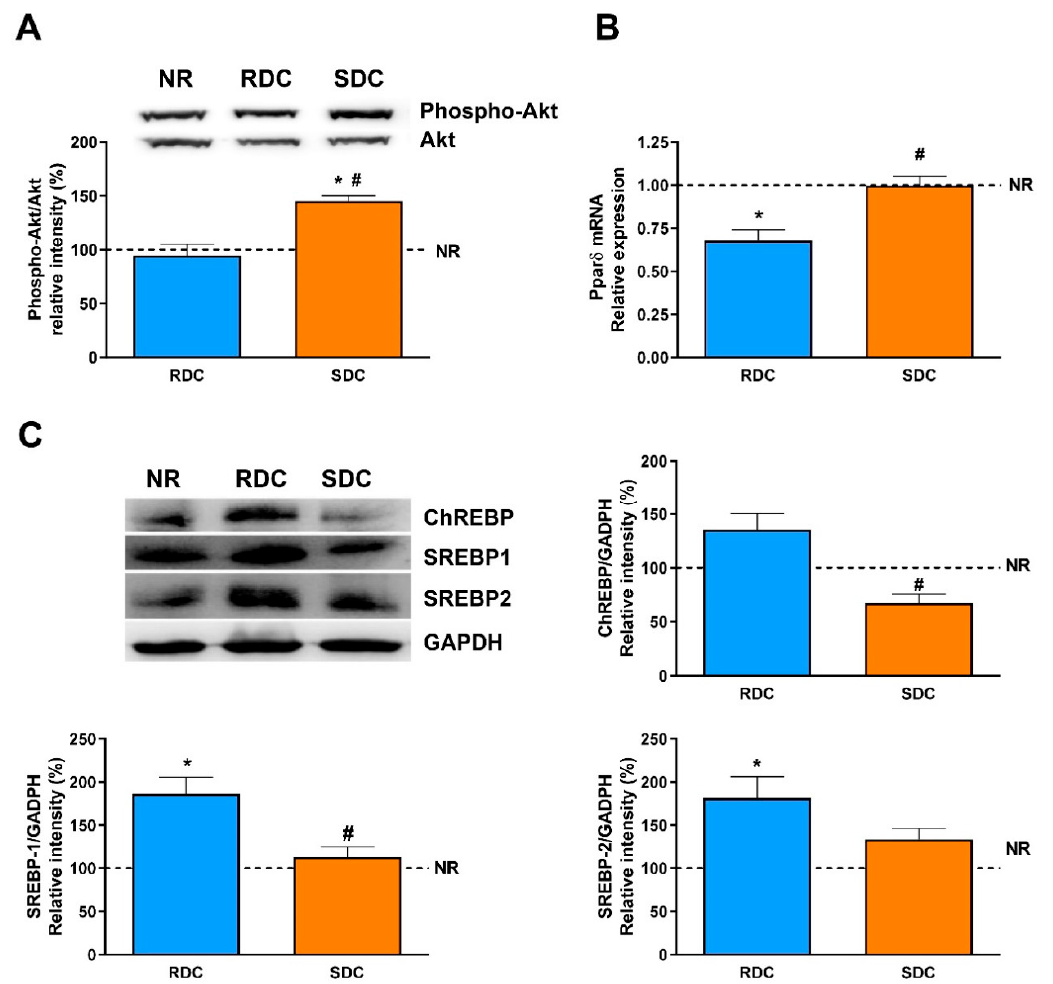
Figure 7. Signaling pathways and di ff erentiation in muscles of the di ff erent experimental groups. ( A ). Protein Kinase B / Ak strain transforming (PKB / Akt) phosphorylative status and ( B ) peroxisome proliferator-activator receptor gamma (Ppar δ ) expression. ( C ). Expression of carbohydrate response element binding protein (ChREBP), steroid response element binding proteins (SREBP1 and SREBP2). NR group, not restricted; RDC group, re-feeding with rapid digestible CHO diet; SDC group, re-feeding with slow digestible CHO diet. * Significant di ff erence with NR group, p < 0.05. # Significant di ff erence with RDC group, p < 0.05.